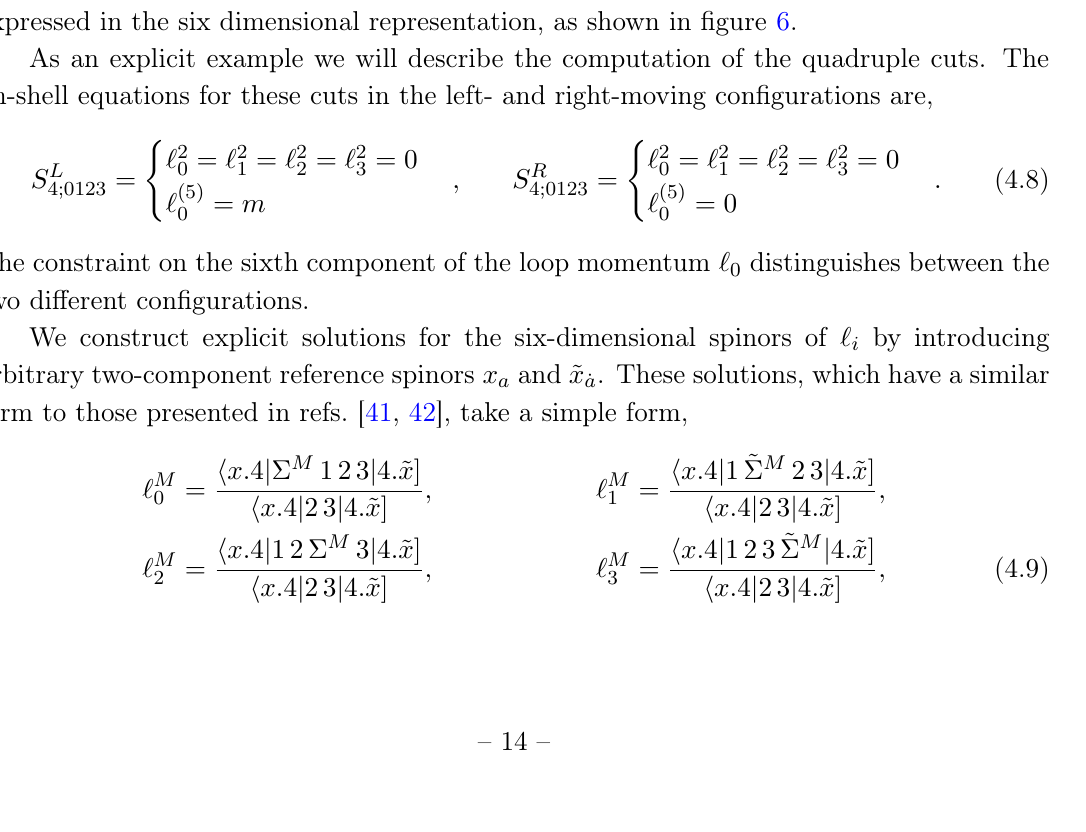
Figure 5 . The complete set of cuts for B [ R ] (1